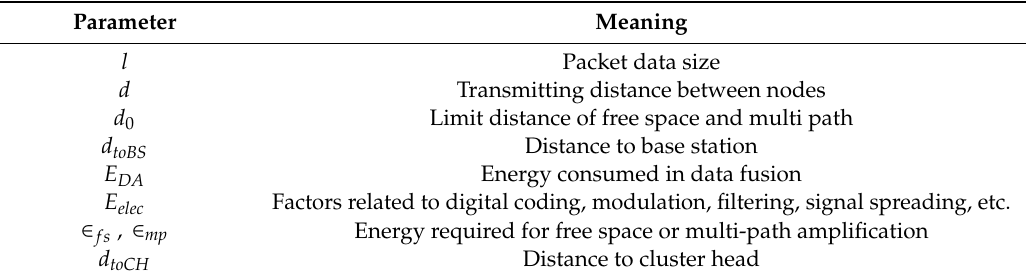
Table 5. Parameters and meanings for the radio model.